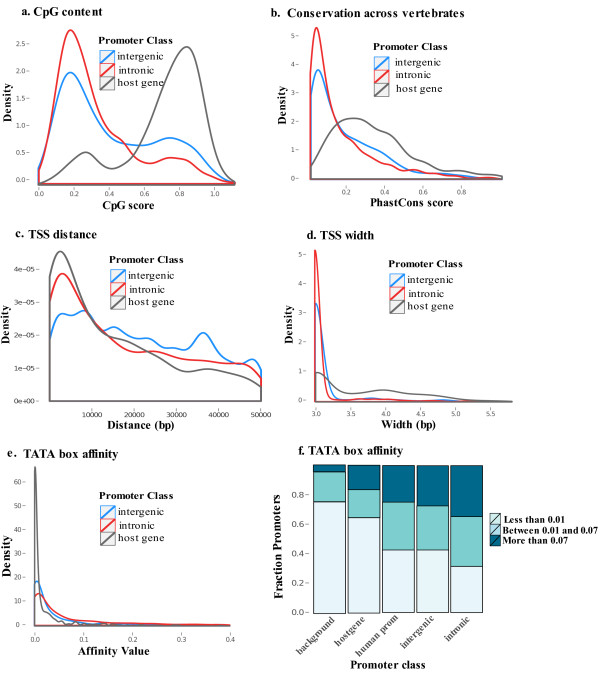
Distribution of promoter features for intergenic, intronic and host gene promoters. (a) Probability density function (PDF) of the CpG score across intergenic (blue), intronic (red) and host gene (gray) promoters. (b) PDF of the conservation score, calculated from the PhastCons vertebrate UCSC track, across intergenic, intronic and host gene promoters. (c) PDF of the distance between intergenic, intronic and host gene TSSs from miRNA precursors. (d) PDF of transcription start site (TSS) width, shown as log10(width) for clarity, for intergenic, intronic and host gene promoters. (e) PDF of the TATA box affinity values, calculated using TRAP, for intergenic, intronic and host gene promoters. (f) Bar plot showing the fraction of promoters that have a TATA box affinity lower than 0.01, in the range between 0.01 and 0.07 or higher than 0.07 for intergenic, intronic and host gene promoters, as well as for all human promoters and background regions. The two affinity levels of 0.01 and 0.07 correspond to the median and upper quantile affinity values for human promoters, respectively.bp, base pair; miRNA, microRNA; PDF, probability density function; TSS, transcription start site.